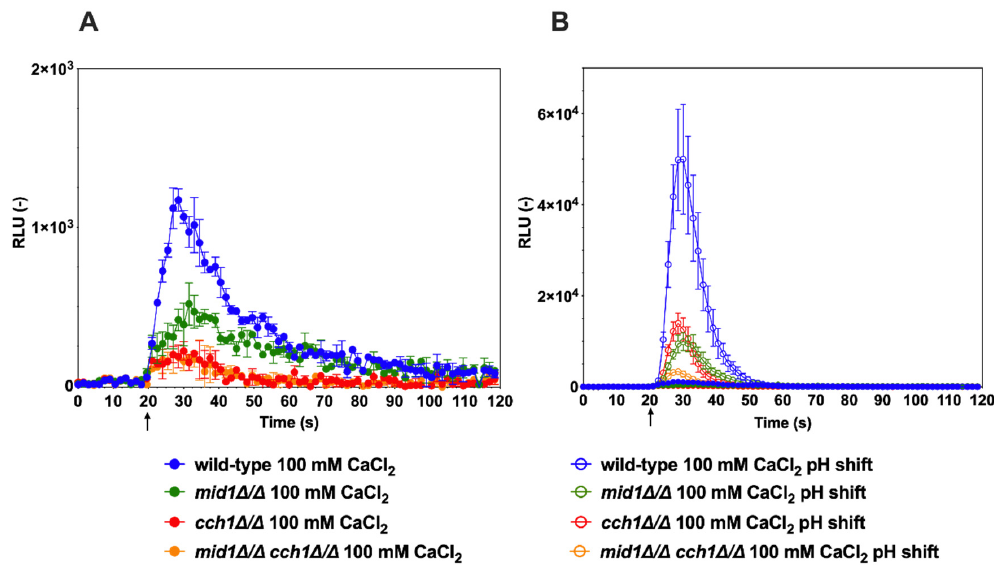
Figure 1. ( A ) Immuno-detection of aequorin in C. albicans by Western blot. Protein extracts were obtained as described in the Materials and Methods. Loading control images were obtained by Congo red staining of the nylon membrane after protein transfer. Pre-stained molecular weight standards are indicated at the left side. Designation of C. albicans isolates is indicated at the top. Aequorin signals (relative values) were quantified as described in the Materials and Methods using aequorin abundance signals of DSY3892 for reference and are indicated for each protein extract. Details of strain genotypes can be found in Table S1. wt: wild-type; wt control: untransformed wild-type. ( B ) Total luminescence emission of permeabilized C. albicans DSY3892 cells (Table S1). Cells were prepared as described in the Materials and Methods. SDS injection was performed after 10 s of pre-incubation in GLAC medium (arrow). Results were obtained from duplicate experiments and data were subtracted from the background in cells devoid of aequorin expression (CAF2-1). RLU: relative luminescence unit.